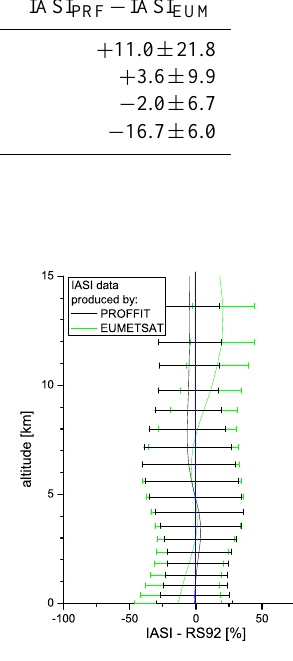
Fig. 9. Statistics of difference between IASI and Vaisla RS92 H 2 O profiles. Black line for IASI PROFFIT-nadir and green line for IASI EUMETSAT profiles, respectively.